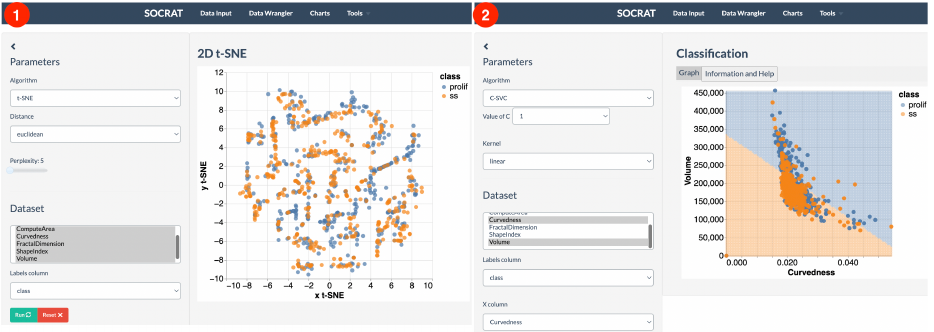
Figure 11. Interactive analysis of cell morphometry dataset: ( 1 ) unsupervised nonlinear dimensional- ity reduction using the t-SNE algorithm; ( 2 ) supervised classification using the SVM